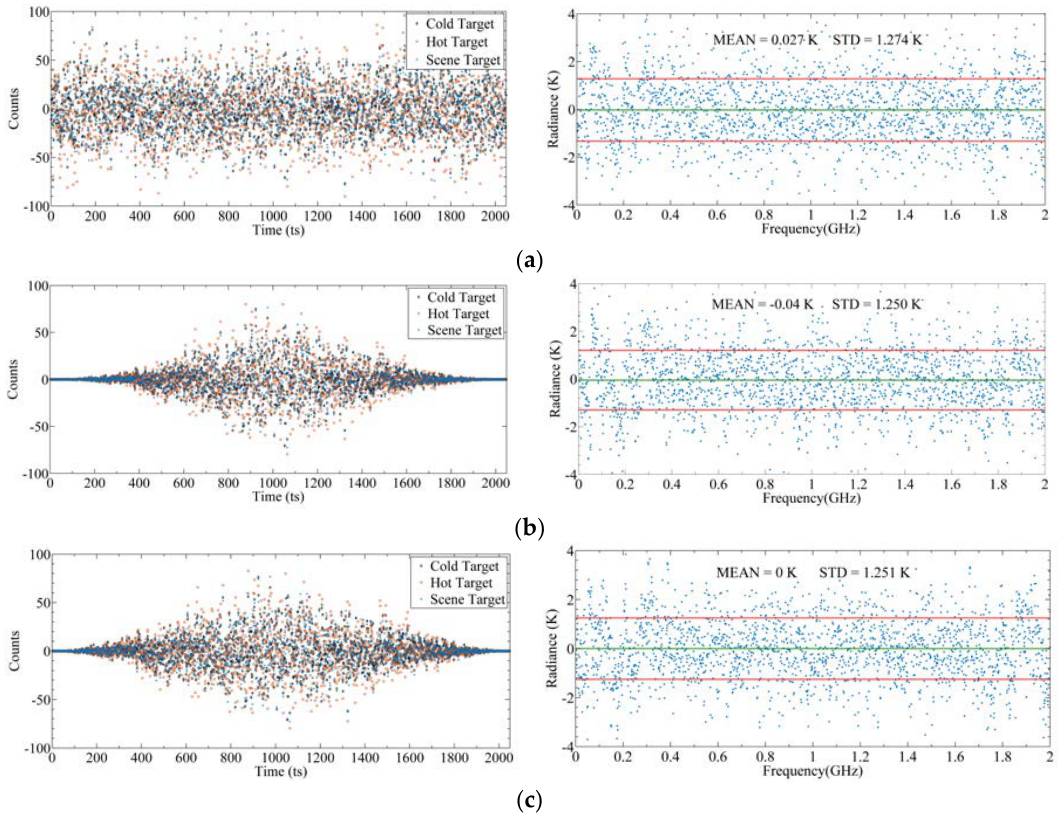
Figure 19. Backend signals and corresponding sensitivities with di ff erent window functions: ( a ) Rectangular window; ( b ) Hanning window; ( c ) Blackman window. The left figures represent output signals after quantization, and the right figures represent corresponding di ff erences between input radiance and output